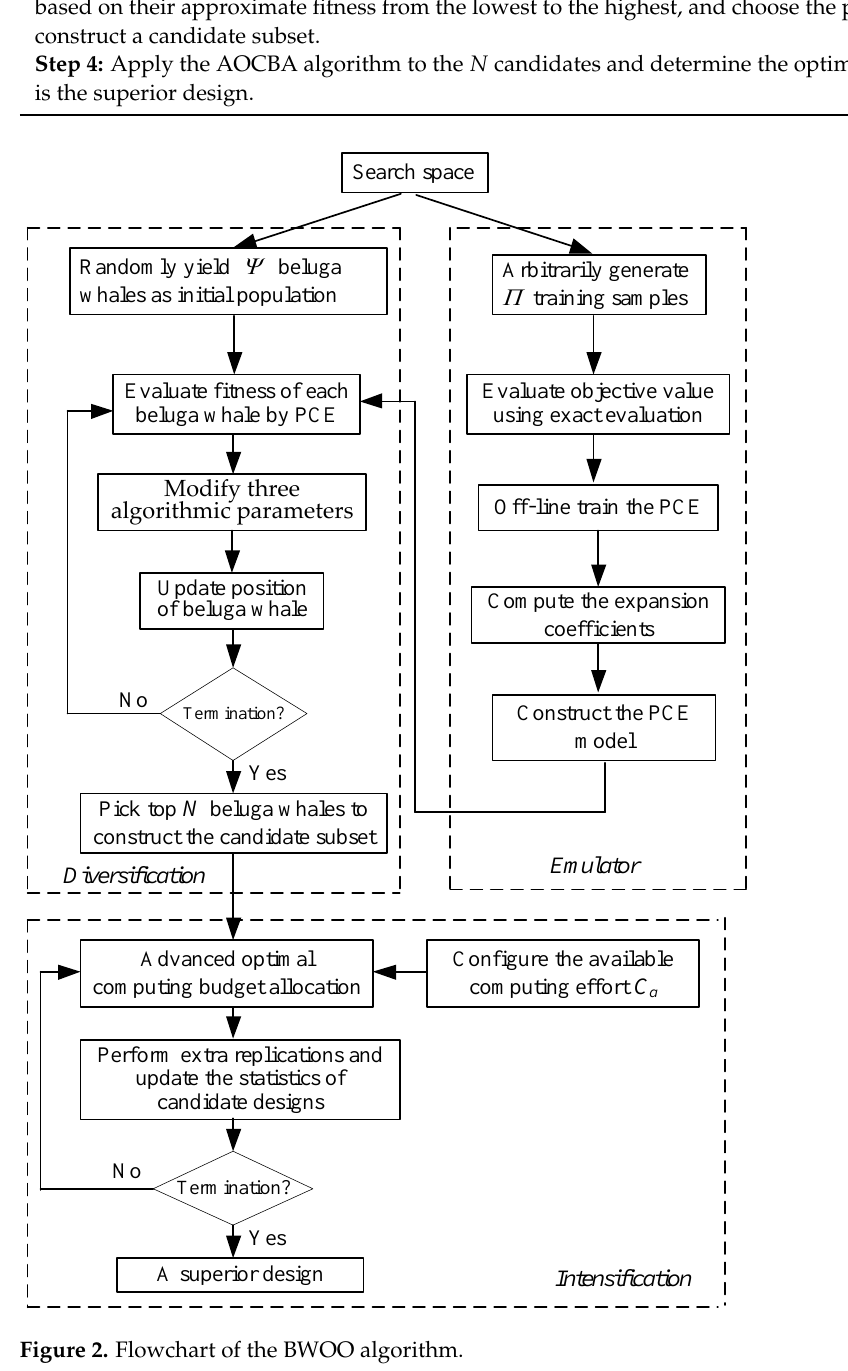
Figure 2. Flowchart of the BWOO algorithm.